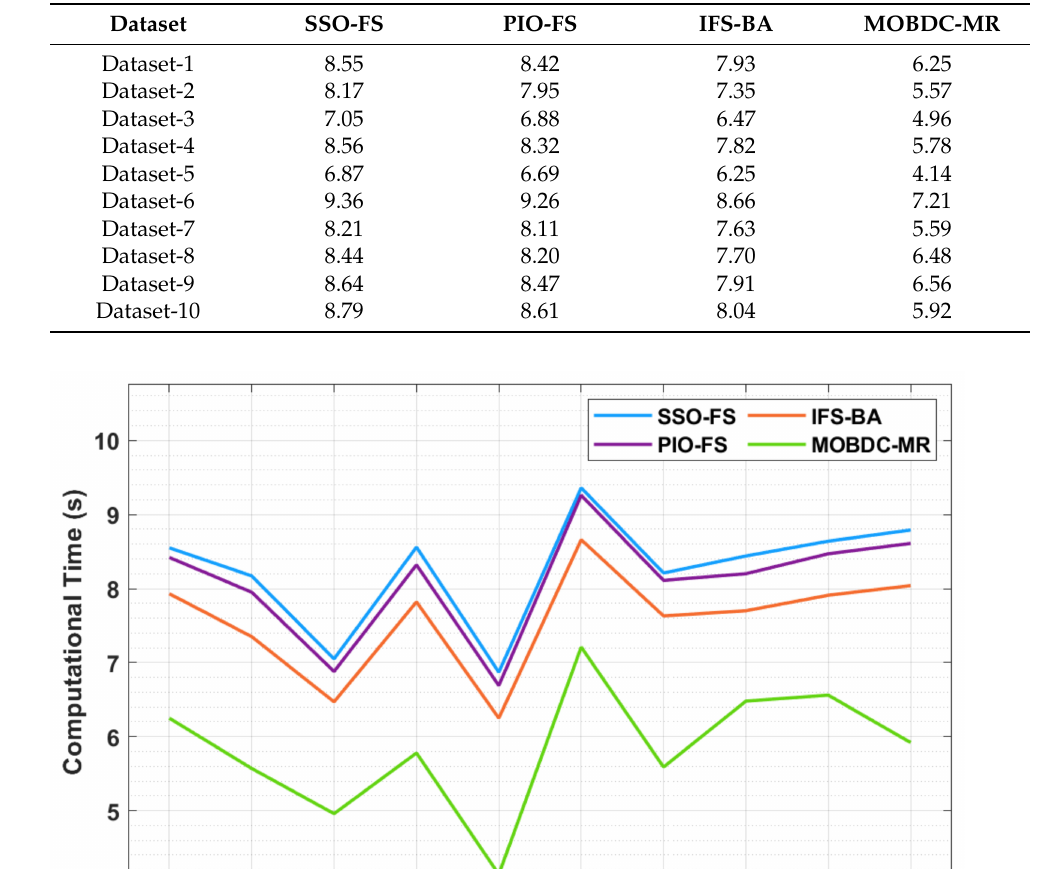
Table 5. Results of the various methods in terms of computation time (s).